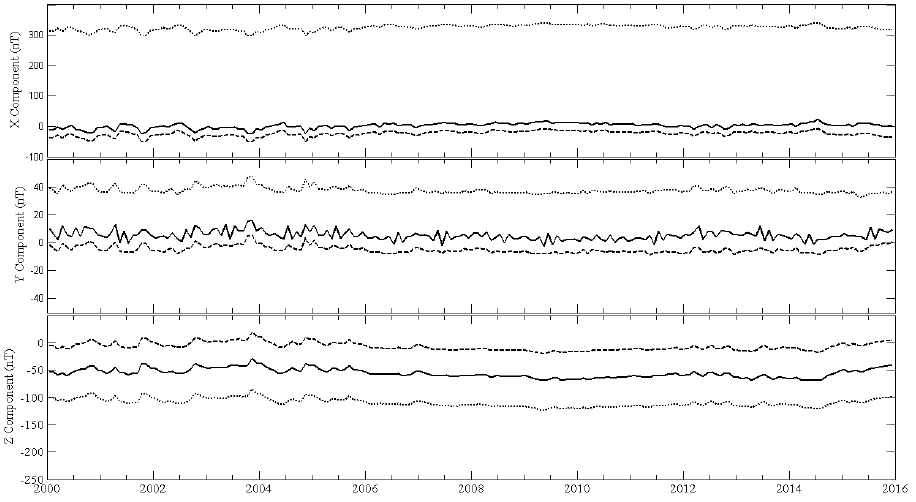
Figure 2. Differences between monthly mean values observed at Niemegk observatory and respective values predicted by EMM2015 model (dashed line), POMME-9 model (solid line) and CM5 model (dotted line). NGK EMM2015 model POMME-9 model CM5 model averaged “bias” (in nT) averaged “bias” (in nT) averaged “bias” (in nT)